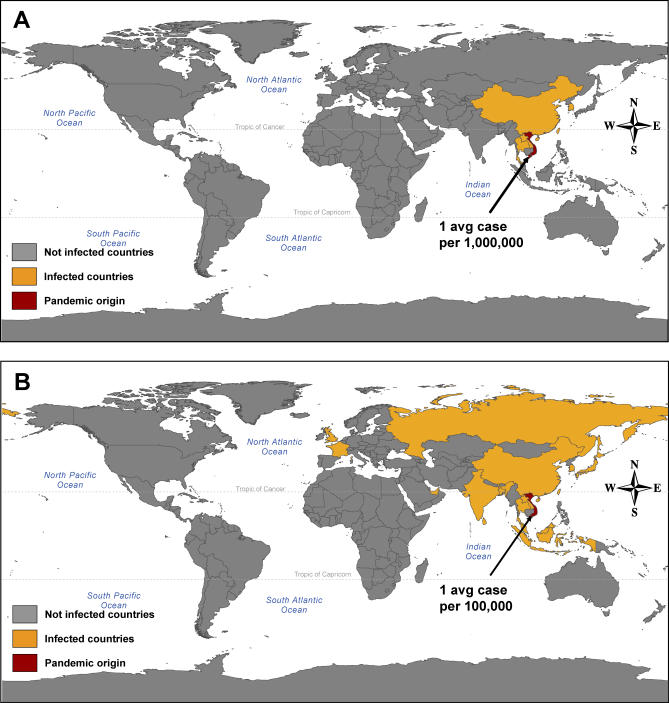
Importance of Air Travel in the Worldwide Spread of Pandemic InfluenzaThe two snapshots show the countries in orange that have a nonnull probability of being infected by the time Vietnam (seeded country) experiences an attack rate of 10−6 (A) and 10−5 (B) cases. Results refer to a pandemic originated in Hanoi in October with R0 = 1.9, with the assumption of unlimited AV supplies available. A country is defined as infected (experiencing an outbreak) if at least one generation of secondary cases occurs. Although the number of cases inside Vietnam is very low, the virus has already propagated out of the initial borders to other countries, thus providing several different seeds for the worldwide spread of the disease. Maps are obtained from open source geographic data and plotted with ArcGIS software.